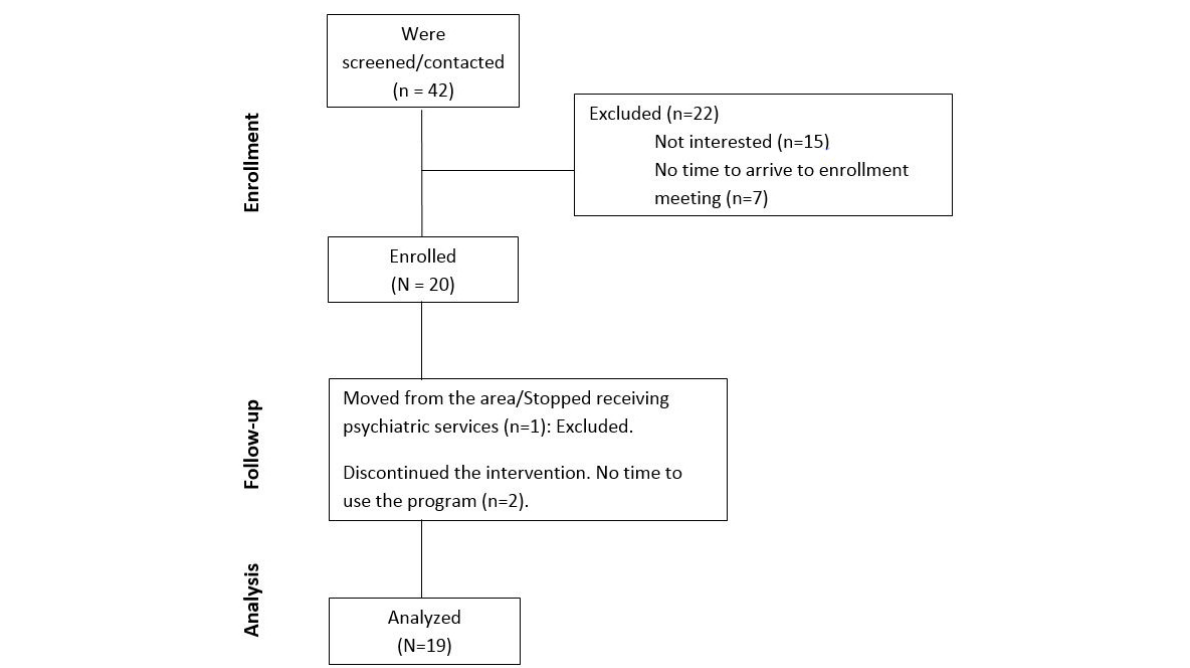
Figure 4. Consolidated Standards of Reporting Trials diagram of participant